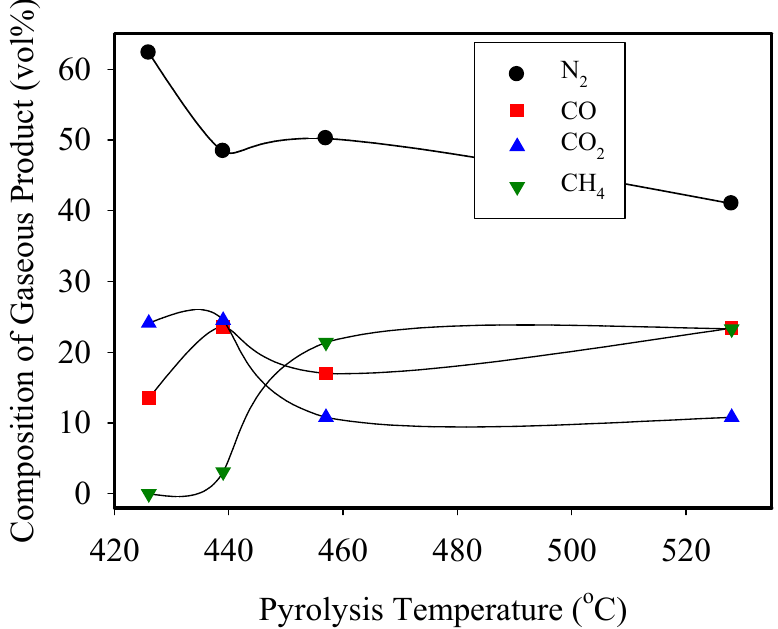
Figure 8. Variation in composition of gaseous product with pyrolysis temperature (0.8 kg/h feeding rate, 15 L/min N 2 carrier gas flow rate).